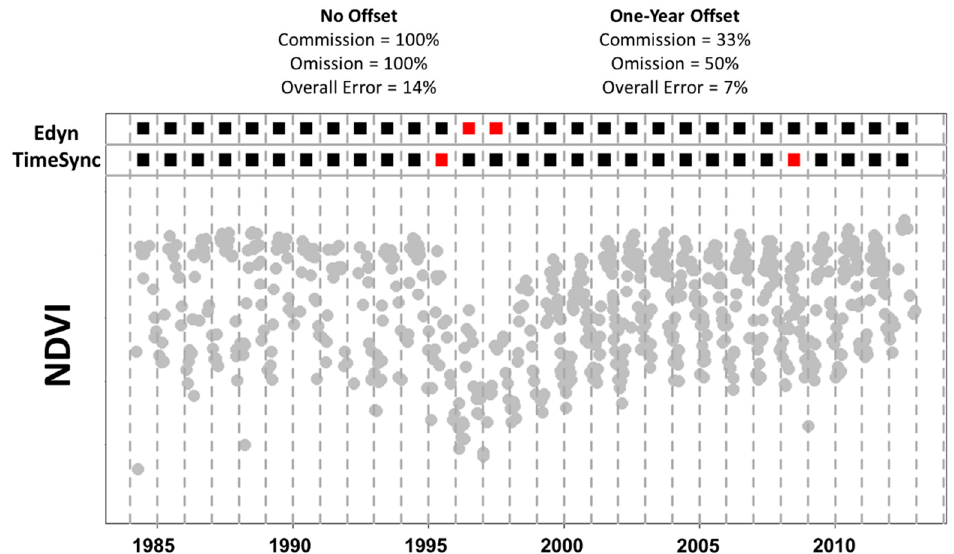
Figure 8. Effect of the one-year offset on error rates of Edyn and TimeSync algorithms, for an example time series (29 years). Note that the offset “extends” the disturbance signal for a given year if and only if there is a pre-existing disturbance signal from the other data source within one year.